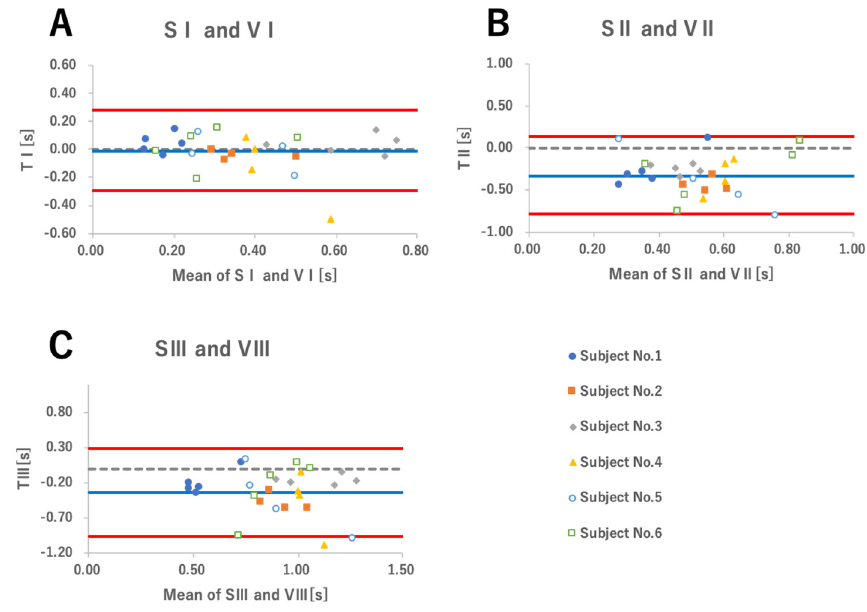
Figure 6. Bland–Altman plot. The X-axis shows the average value (seconds) of the measurement pairs and the Y-axis shows the difference (seconds) between the methods. The blue line on the graph shows the average value of the difference between the two measurement methods, and the red line shows the limits of agreement. ( A ) VI and SI. TI had a mean difference of − 0.01 ± 0.14 s. Neither fixed nor proportional error was observed. ( B ) VII and SII. TII had a mean difference of − 0.33 ± 0.23 s. There was a fixed error, but no proportional error was observed. ( C ) VIII and SIII. TIII had a